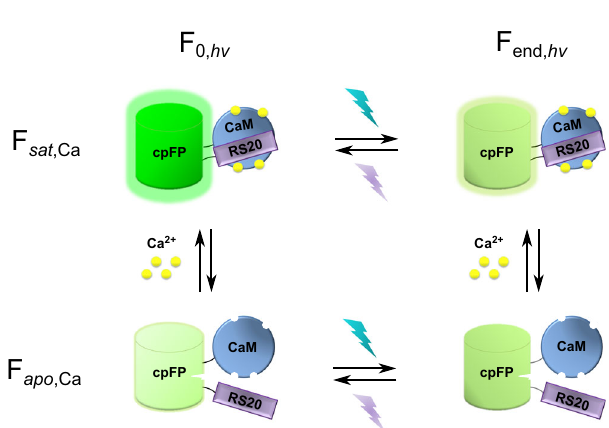
Fig. 2 Schematic model for a single-FP-based photochromic sensor, involving the presence of four different states as determined by the absence or presence of Ca 2 + and the spectroscopic on- or off-state. In the sat state the cyan and violet light cause off- and on-switching of the fl uorescence, respectively, which is reversed in the apo